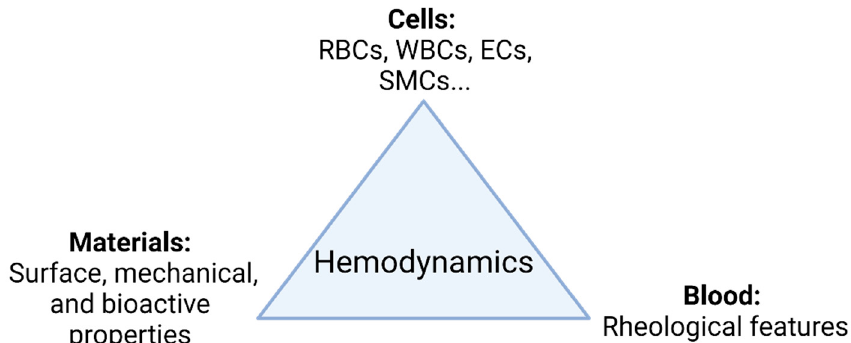
Figure 1. TEVG triad. Regeneration is mainly governed by the interplay of involved cells, biomaterials, and the microenvironment. Changes in the hemodynamic context directly impact how the interplay of the parameters takes place and ultimately the performance of the TEVG under functional physiological conditions (Created with BioRender.com, accessed on 7 November 2021).